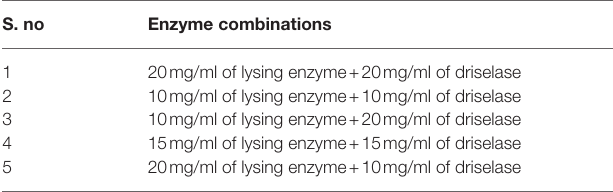
TABLE 1 | Enzyme combinations for strain D-1 protoplast preparation.